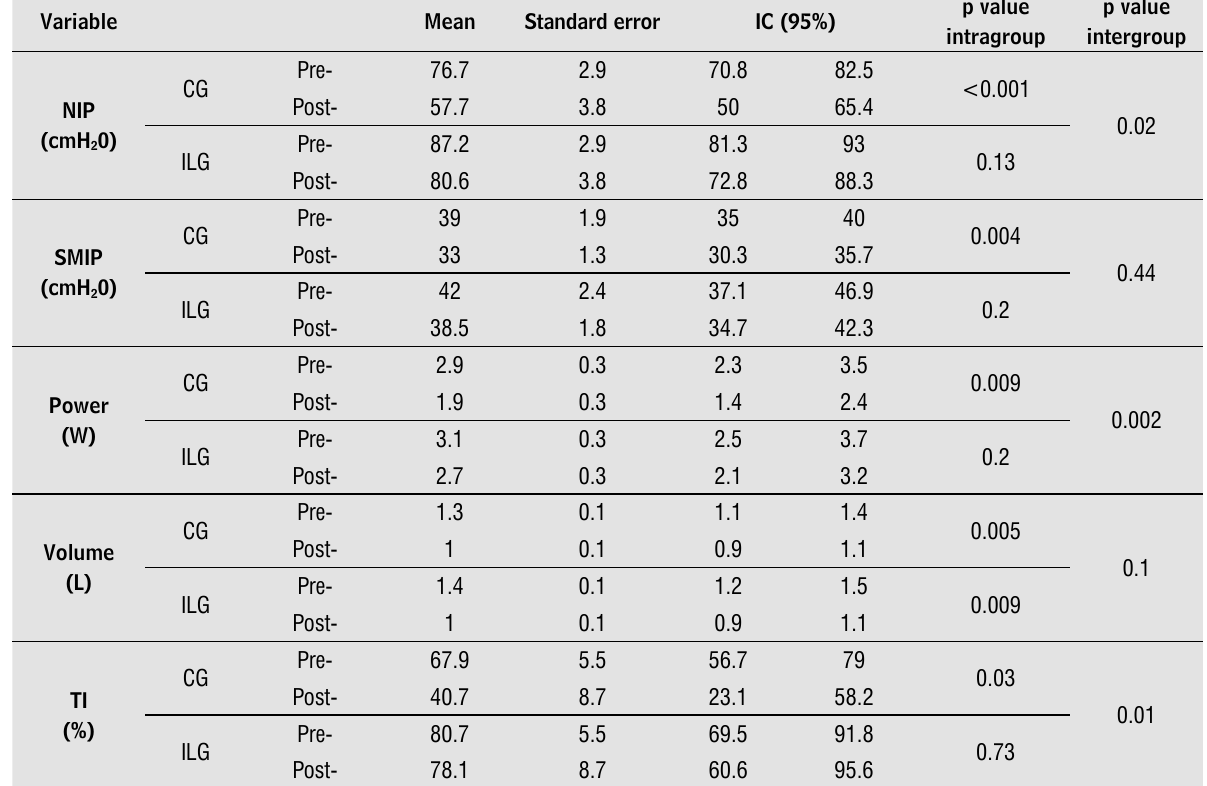
Table 2 – Values obtained for NIP, SMIP, power, volume and the training index in the pre- and post-operative periods Variable Mean Standard error